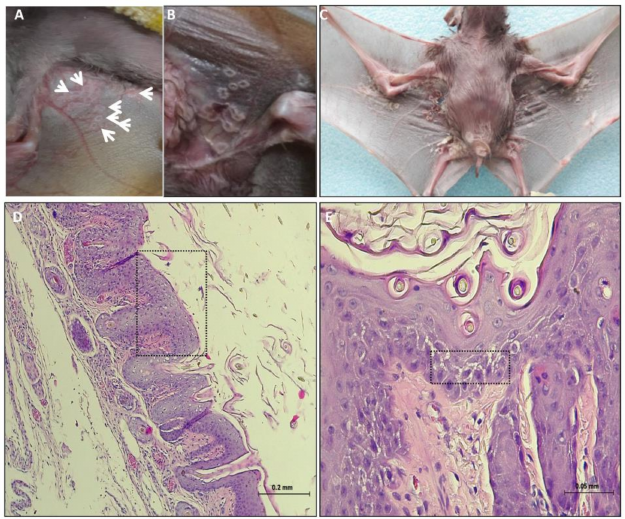
Figure 1. Development of skin lesions caused by poxvirus disease like in suckling bats. ( A ) Lesions on the ventral wing skin of bat no. 1334 marked by white arrows. ( B ) Progression of the Scheme in Figure 4. ( C ) PM examination showing gross pathology. ( D ) Histology of skin wing lesion, epidermis is hyperplastic, with pegs and nests extending into the inflamed dermis. Black rectangle point to a region with Acanthosis, vacuolar changes (ballooning) and reticular degeneration. ( E ) Higher magnification of (D) showing a dermal nest of epithelial cells with cytoplasmic rounded degeneration. Black rectangle point out a region with